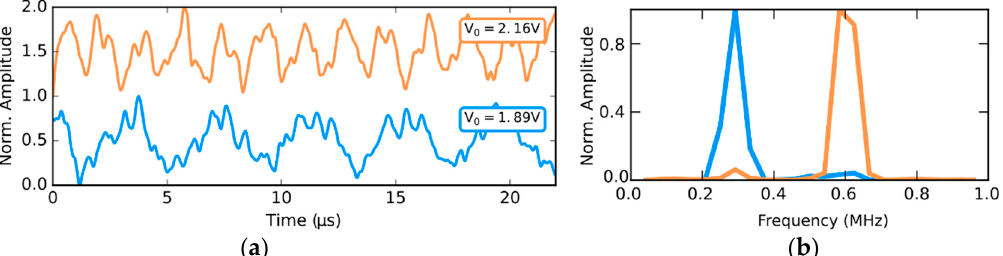
Figure 3. Selective excitation of different mechanical modes of a VO 2 -based microbridge under DC bias. ( a ) Time plot of the microbridge deflection as measured by an optical lever setup for two different values of V 0 . ( b ) Fourier Transform of ( a ) showing the dominant harmonic components of the signal, corresponding to the first (blue) and second (orange) flexural mode of the structure in Figure